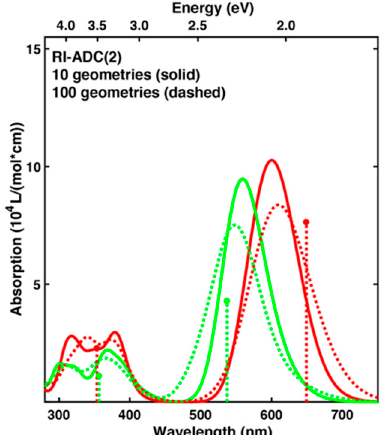
Figure 2. Absorption spectra for the P r (red) and P g (green) forms calculated with RI-ADC(2) / cc-pVDZ for QM66. The spectra are either based on 10 snapshots from a QM / MM MD trajectory taken every 100 ps (solid) or on 100 snapshots taken every 10 ps from the same trajectory (dotted). The sticks represent the positions and relative intensities of the two lowest energy absorption maxima for each form extracted from the measured spectra [14].